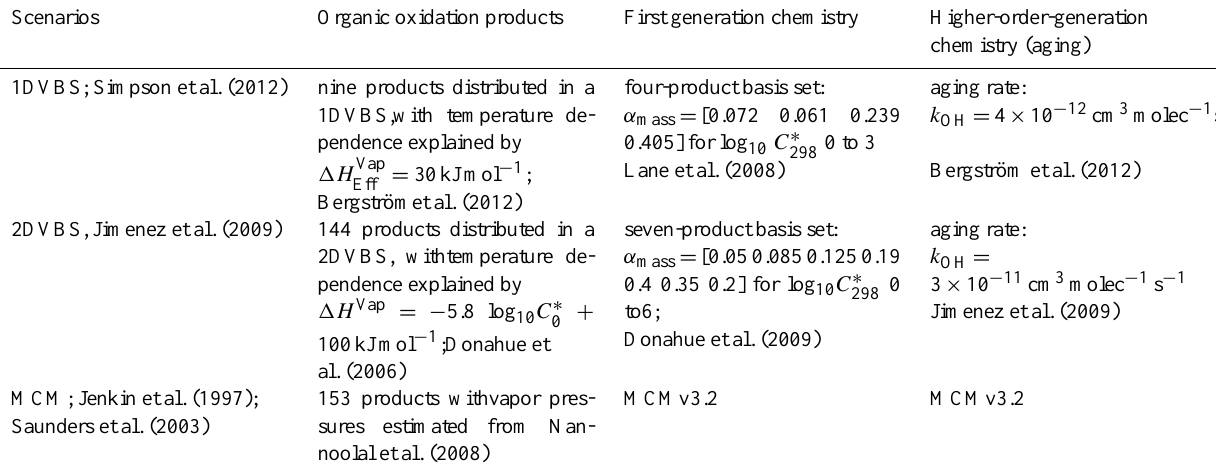
Table 2. Details of the three base case gas-phase schemes investigated in this study. Scenarios Organic oxidation